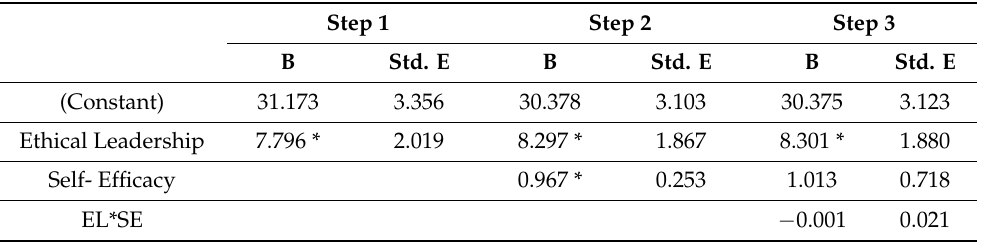
Table 4. Result of hierarchical regression analysis for the effect of ethical leadership on work engagement with moderation effect of self-efficacy.